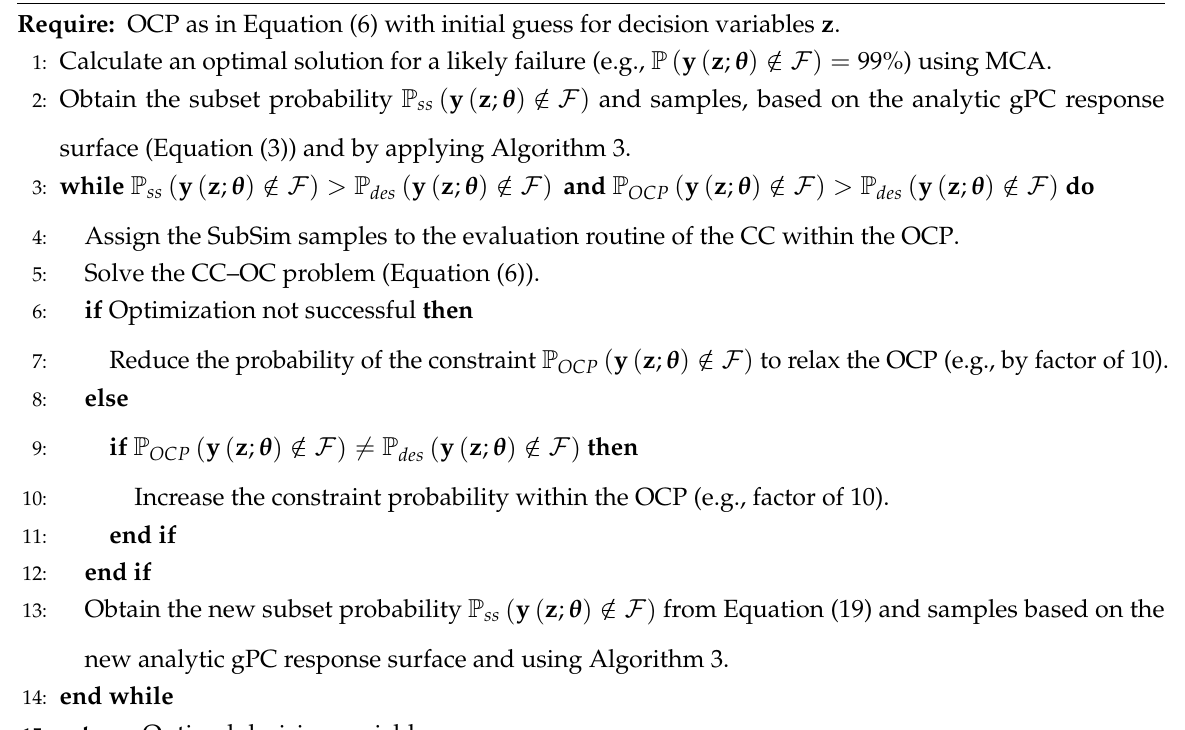
Algorithm 4 Basic strategy of the subset simulation algorithm within CC–OC